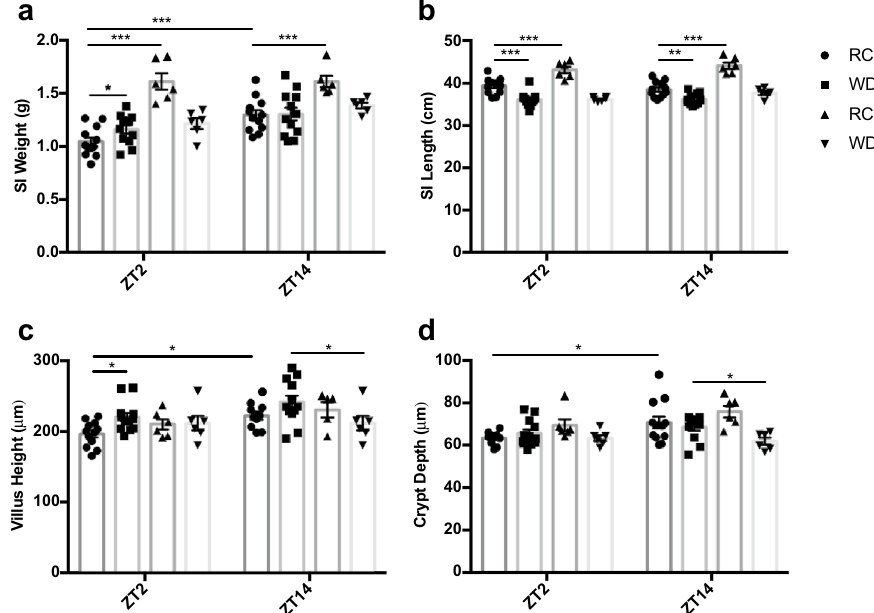
Figure 1. WD-feeding and microbial disruption alter time-dependent patterns in SI gravimetric and morphometric parameters. ( a ) SI weight, ( b ) SI length, ( c ) ileal villus height, and ( d ) ileal crypt depth in RC- and WD-fed animals with and without AIMD measured at ZT2 and ZT14. n = 3–6 male and 3–6 female mice. * p < 0.05 ** p < 0.01 *** p <